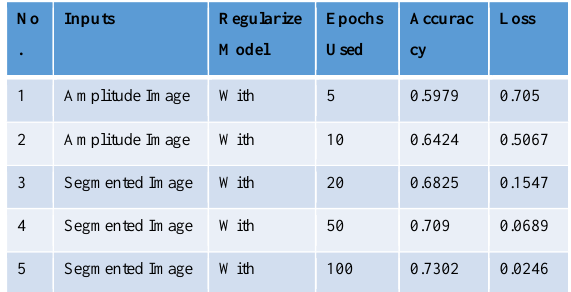
Table 7 . Window Size (256 X 256) Used for the Training of Model